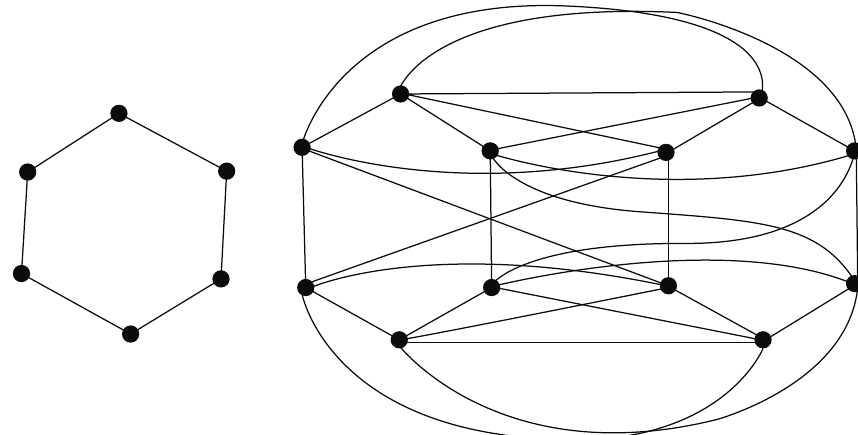
Figure 3: Circumcoronene series of benzenoid ( H